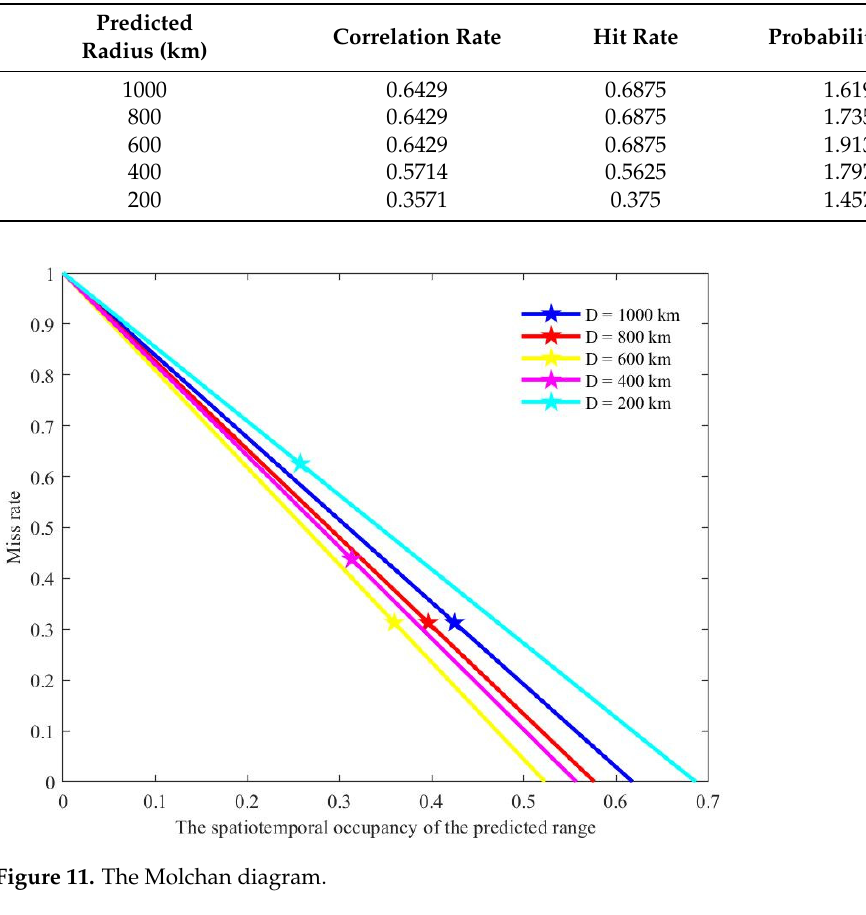
Figure 11. T he Molchan diagram. Figure 11. The Molchan diagram.